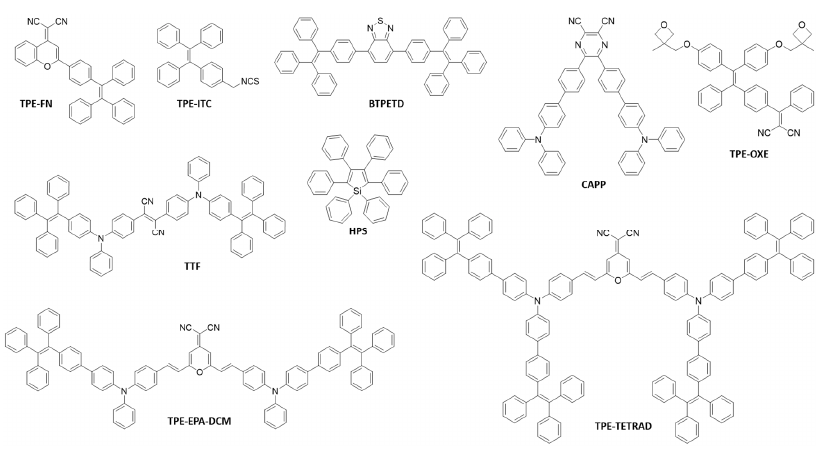
Figure 2. Typical AIEgens employed in nanomaterials fabrication.